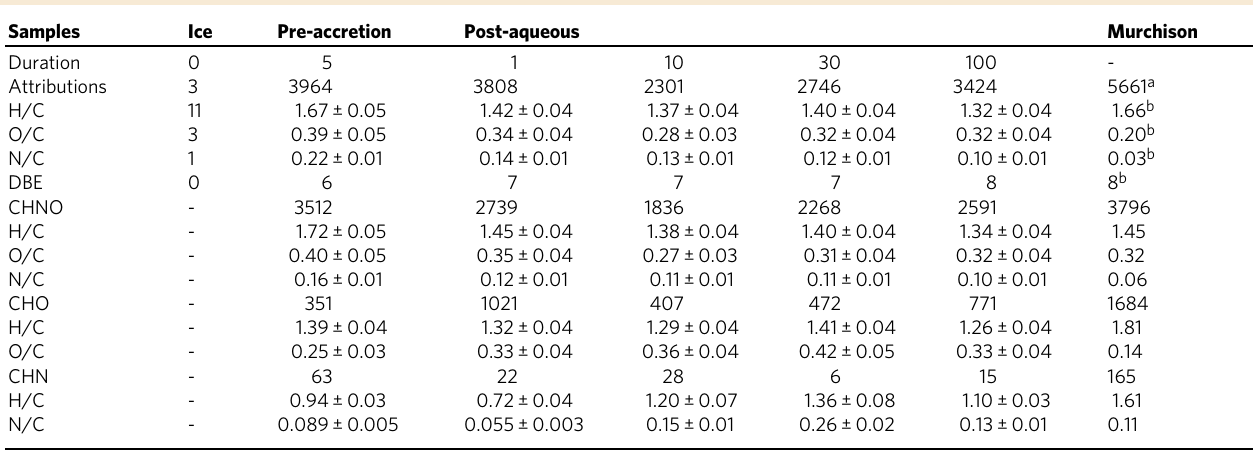
Table 1 Data summary of FT-ICR analyses. Samples